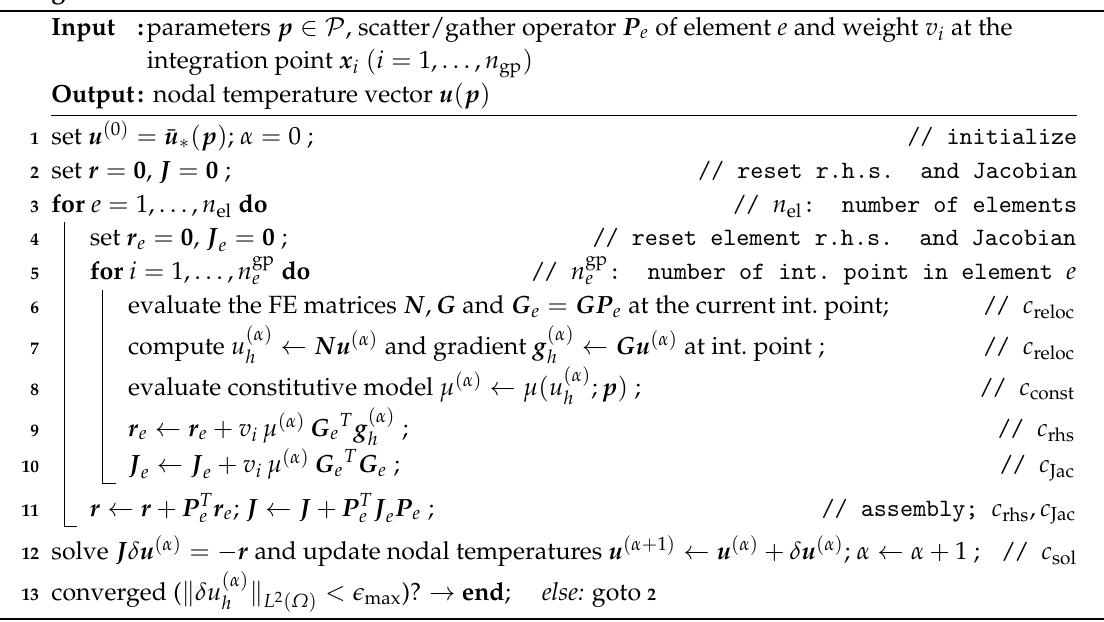
Algorithm 1: Finite Element